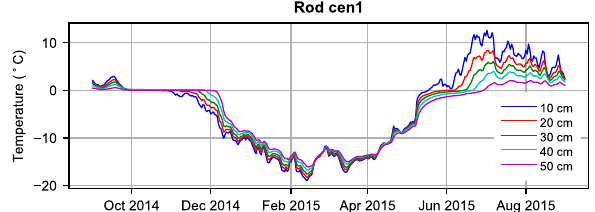
Figure 2. Sample of observed temperature data from sensor rod